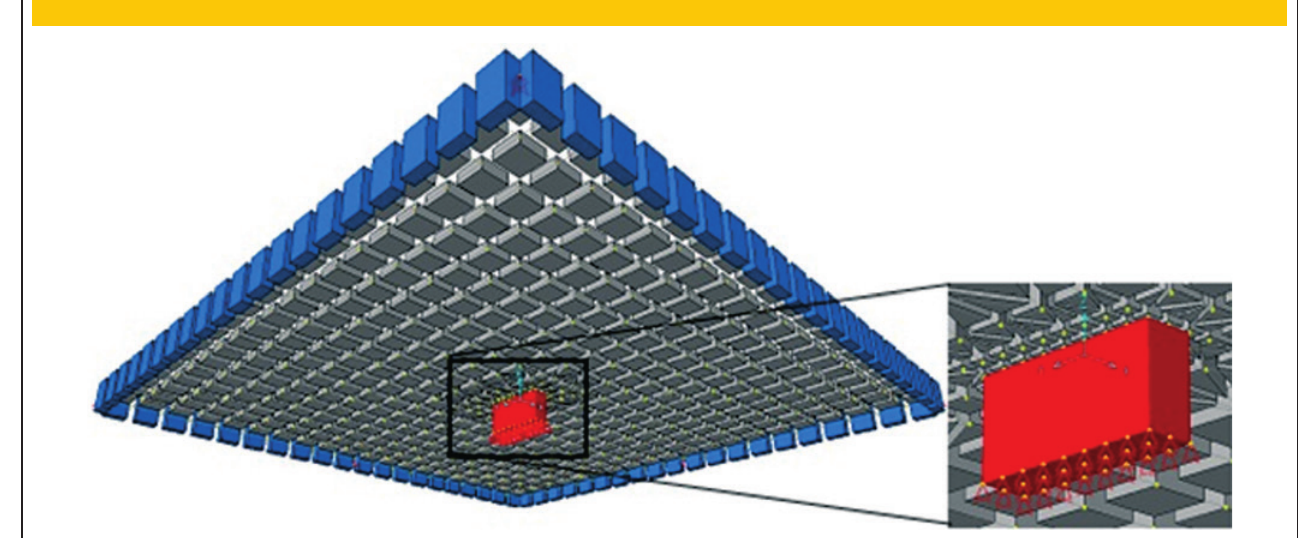
Figure 5 – Column modeled as solid element (HENNRICHS [12])